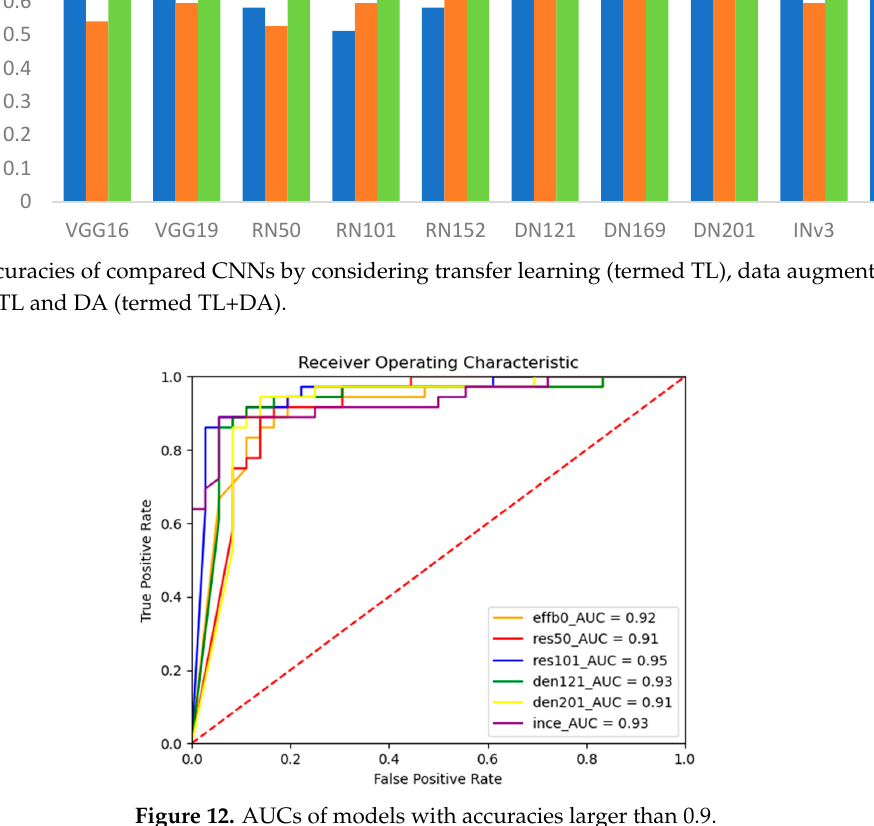
Figure 12. AUCs of models with accuracies larger than 0.9.